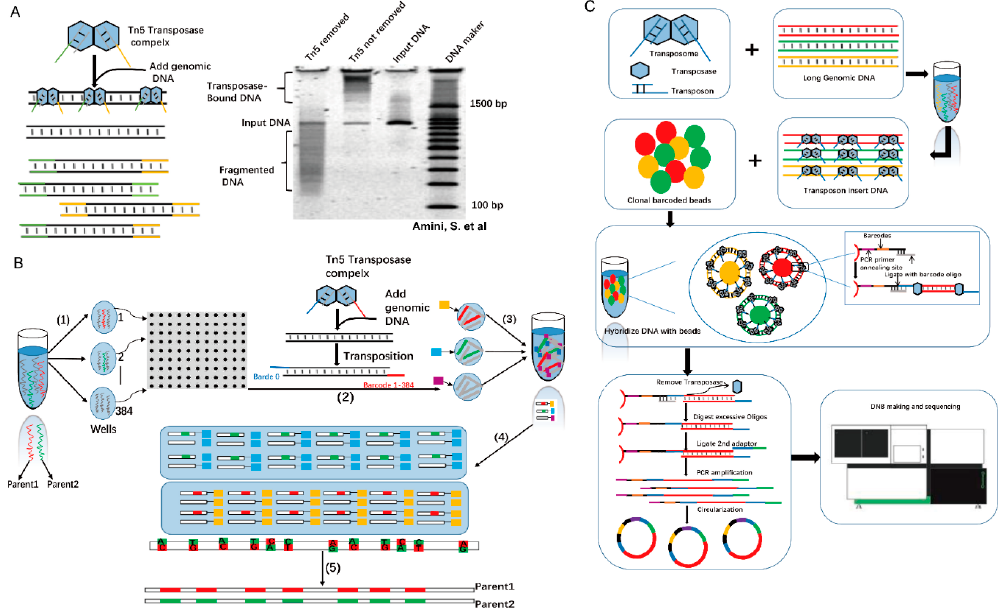
Figure 5. Tn5 is used in long-fragment sequencing. ( A ). PAGE analysis of transposase continuity. Tn5 transposons are used to target 1-kb PCR amplicons. Lane 1, treatment of transposome with SDS to remove transposase; Lane 2, transposome without SDS treatment is used as control. Lane 3, input DNA; Lane 4, a DNA marker. Tn5 transposase remains bound to DNA after transposition, and the protein-DNA complex dissociates only after the addition of the protein denaturant, SDS [30]. ( B ). Principle and scheme for LFR. (1) Physical separation of 100-130 pg of high-molecular weight DNA into 384 di ff erent wells. (2) Through several steps, all in the same well, without